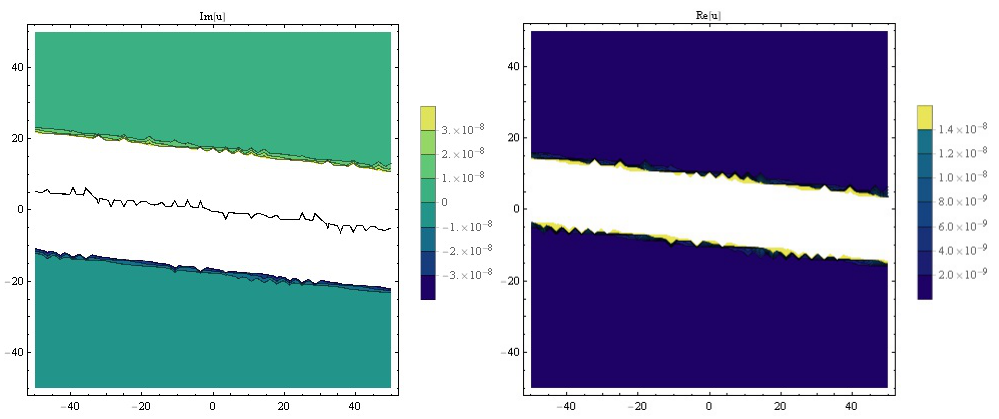
Figure 2. The contour simulations of u 1 for k = 0.1, w = 2, ε = 1, α = 0.4, α 1 = 0.3, α 2 = 4, α 3 = 0.5, y = 0.05.